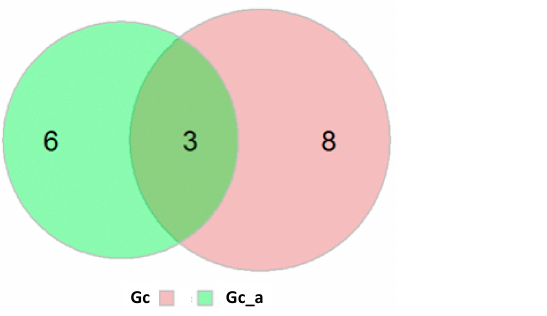
Figure 5. Six bacteria were unique in Gc_a comparing to Gc. Size of the Venn diagram is shown in proportion to the number of bacteria in each group. The 6 unique bacterial names and direction of changing relative abundance are shown on the right.